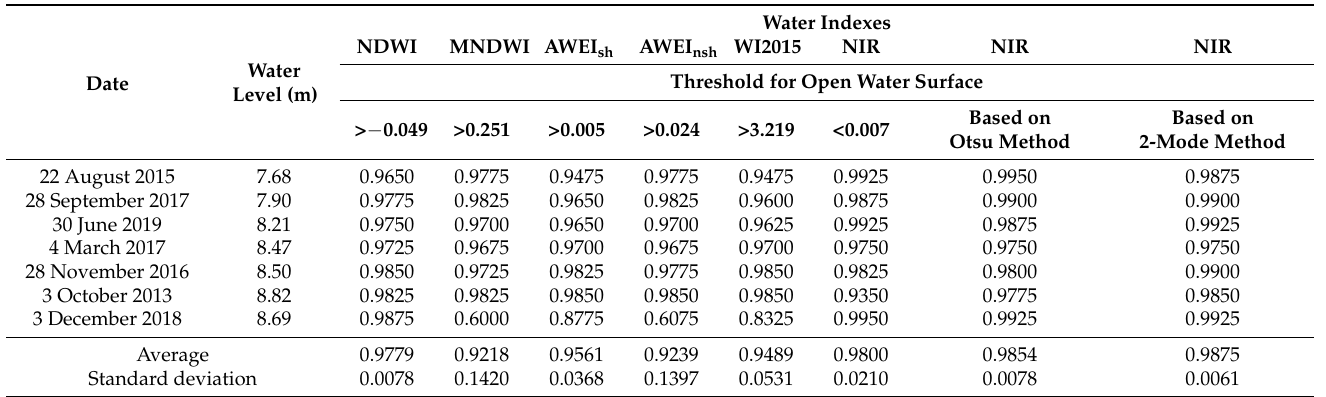
Table 3. Overall accuracies of different open water surface classification